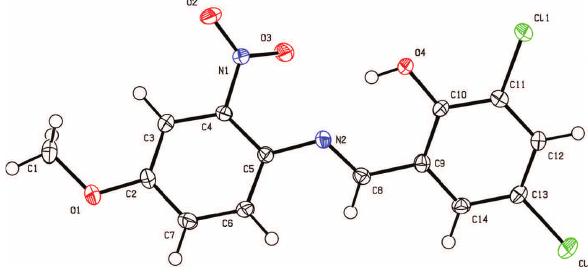
Table 1: Data collection and handling.